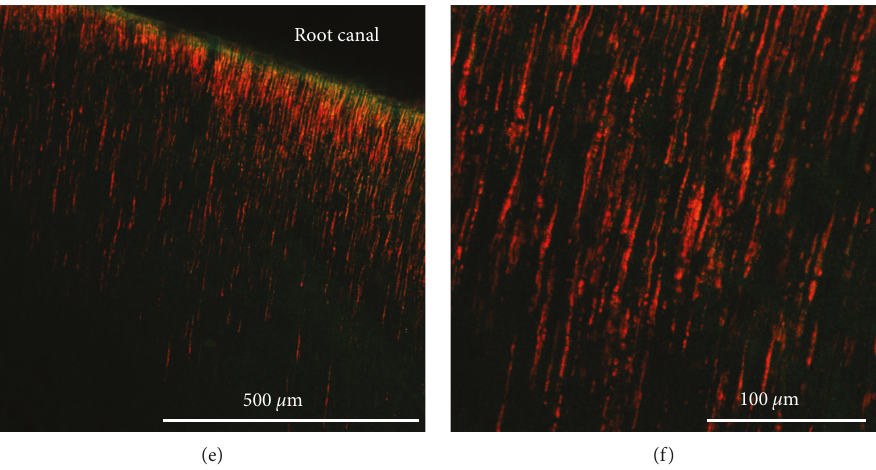
Figure 3: CLSM images of preinfected dental specimens after the corresponding treatment. (a, b) Negative control specimen; (c, d) specimen exposed to CH; (e, f) specimen exposed to SRF-CPC. Pictures in the right column were taken at higher magnification (30x). Red color corresponds to dead bacterial cells and green to viable